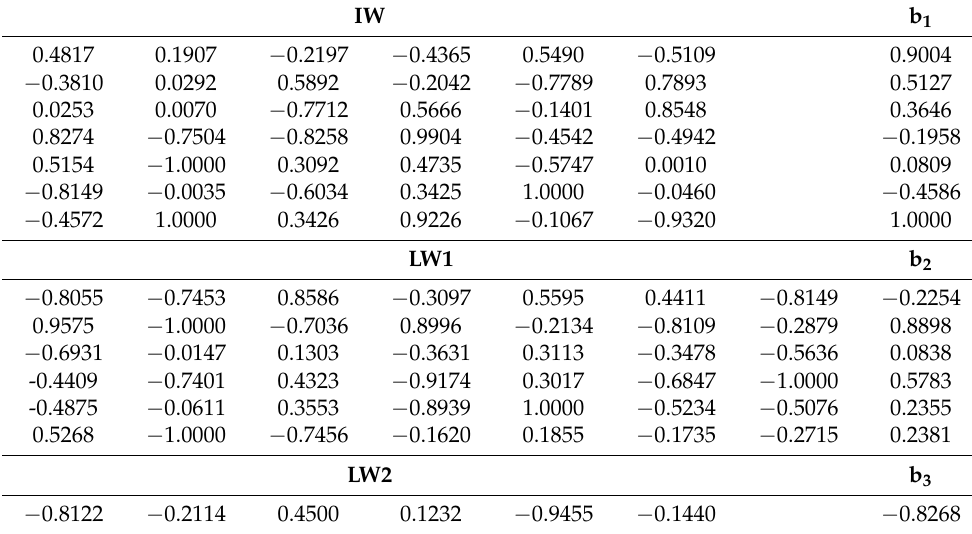
Table 7. Final weights and bias values of the ABC-ANN model for S j,ini (kNm/rad).